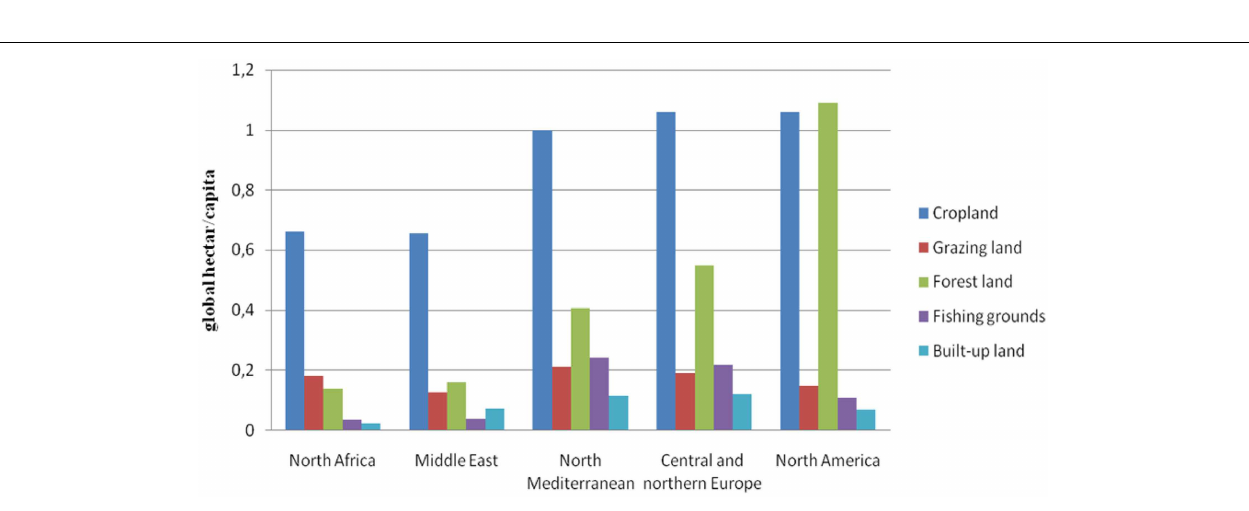
FIGURE 3 | Ecological footprint (in global hectares per capita) by land use type in the Mediterranean [Source: adapted from Ref. (42)]